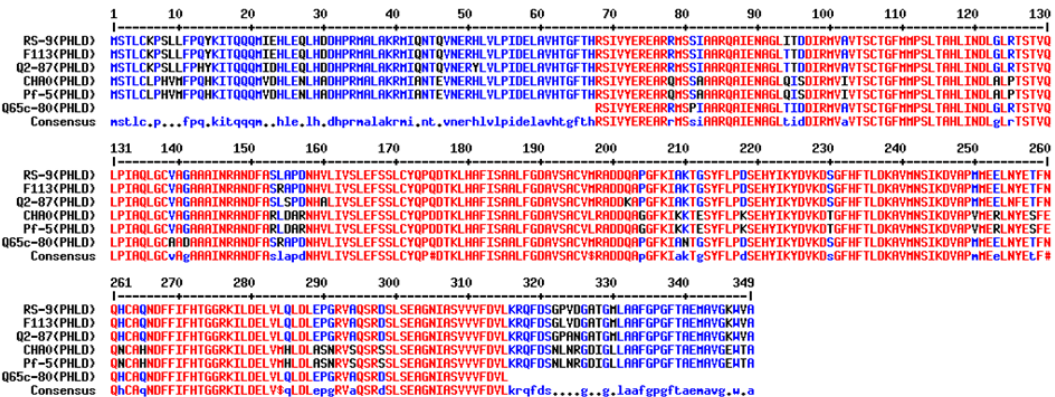
Figure 6. Pairwise sequence alignment of Pseudomonas spp. RS-9 PHLD protein with the PHLD protein from five Pseudomonas strains (http://multalin.toulouse.inra.fr/multalin/, accessed on 15 March 2022). The deduced amino acid sequence from the cloned phl D gene Pseudomonas strain RS-9 showed homology with the already reported PHLD protein from Pseudomonas strain F113, Q2-87, CHAO, and Pf-5.